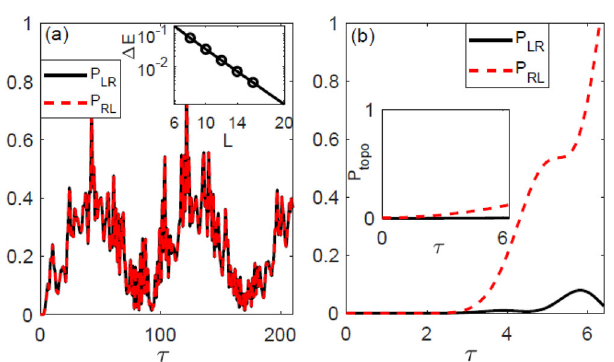
Fig. 5 Topological transport with and without non-Hermitian skin effect. Edge-to-edge transport properties for the topological system without ( a ) and with ( b ) non-Hermitian skin effect. We take Ω 0 = 0.5, Ω r = 0.3, and γ = 0 ( a ), 0.2 ( b ). In the main plots, the system size L = 8. The inset of b shows the contribution from the topological edge states. Here the energy unit is hopping t , and the time unit is ℏ / t